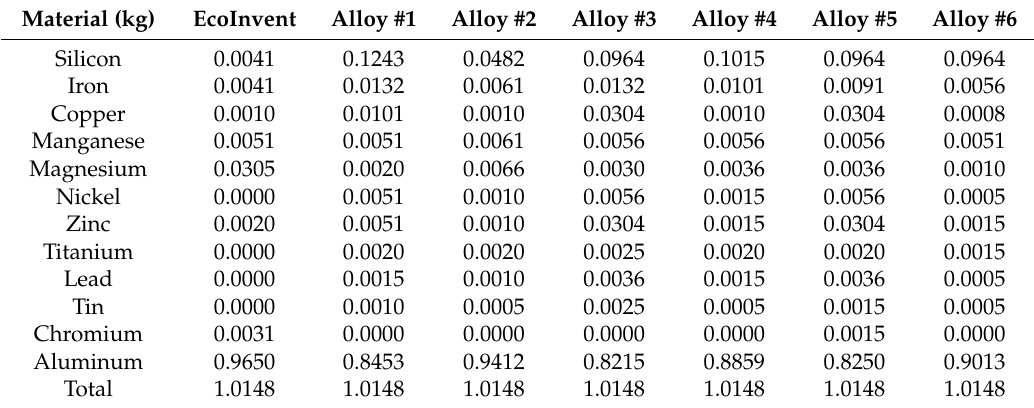
Table 5. Balanced material composition inputs for 1 kg of aluminum